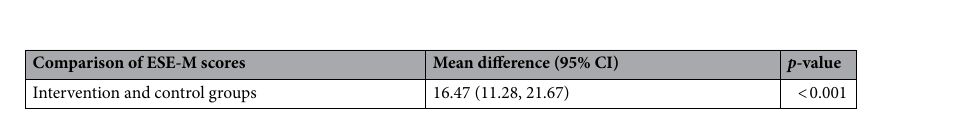
Table 3. The overall mean difference in ESE-M score among the two groups (intervention and